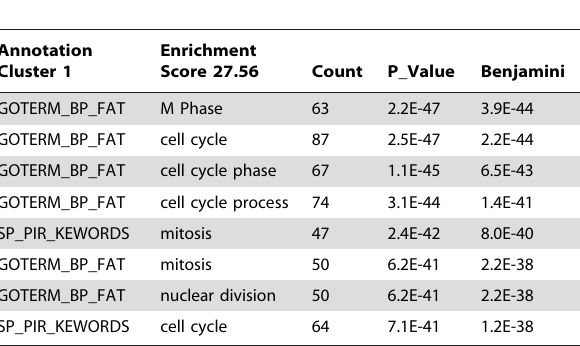
Table 1. Functional Annotation Clustering using DAVID for the top 1200 unregulated genes (Log2 # 5–12) of